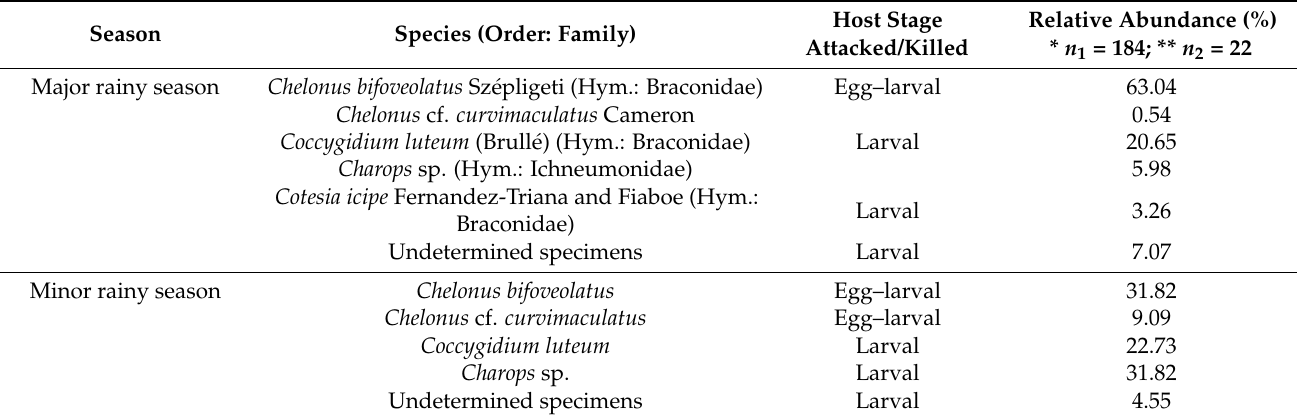
Table 1. Parasitoid species emerged from Spodoptera frugiperda larvae and their relative abundance during the major and minor rainy seasons in 2020.